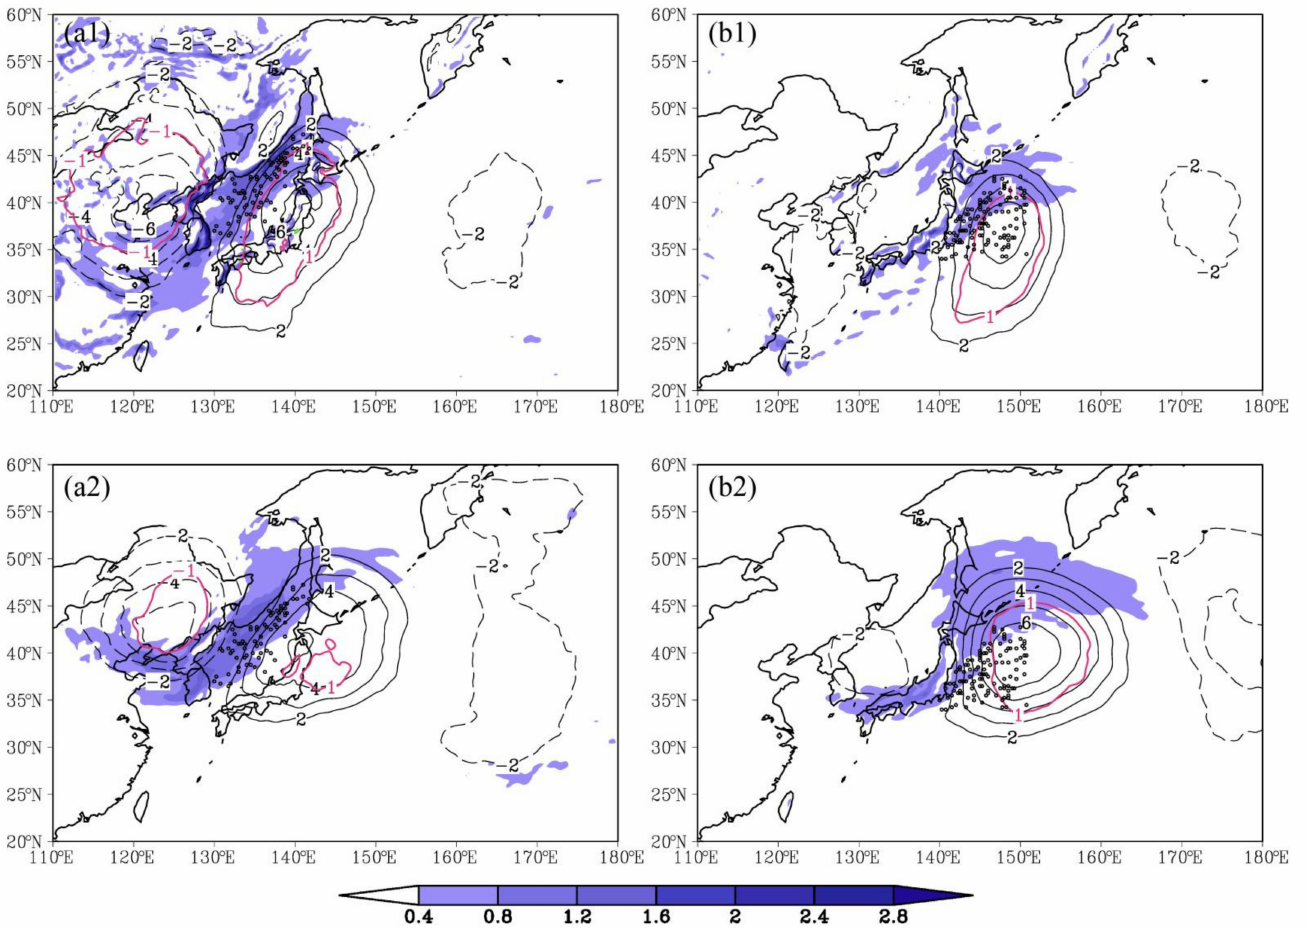
Figure 8. Anomaly fields of composite potential temperature (black line, 1 K intervals) and baroclinic- ity (shaded, 0.4 × 10 − 5 K m − 1 intervals) for ECs at maximum-deepening-rate moment over ( a1 , a2 ) the Japan Sea and ( b1 , b2 ) Kuroshio/Kuroshio Extension at ( a1 , b1 ) 850 hPa and ( a2 , b2 ) 500 hPa. The red line indicates the RAS of potential temperature equal to 1 or −